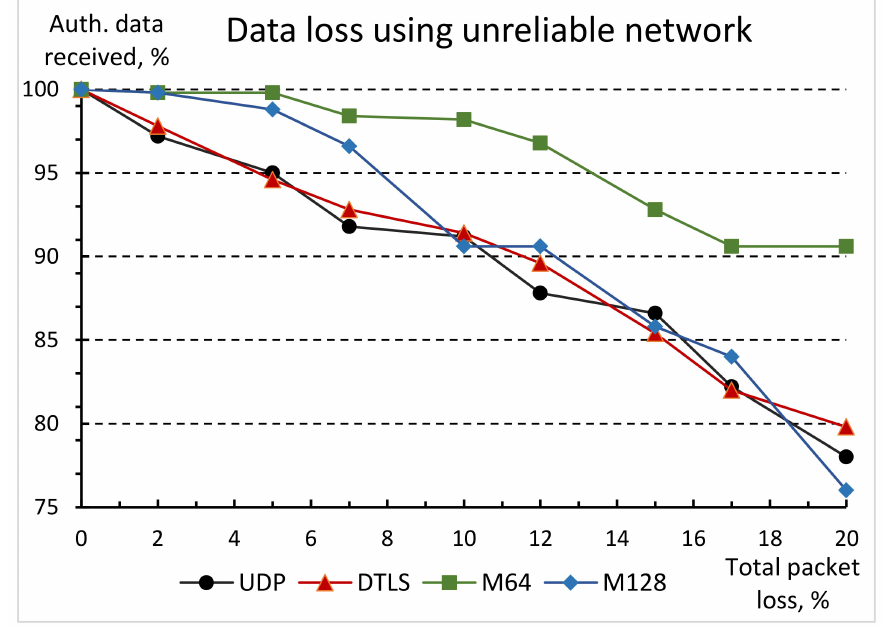
Figure 7. Comparison of user data losses using di ff erent transport protocols in lossy